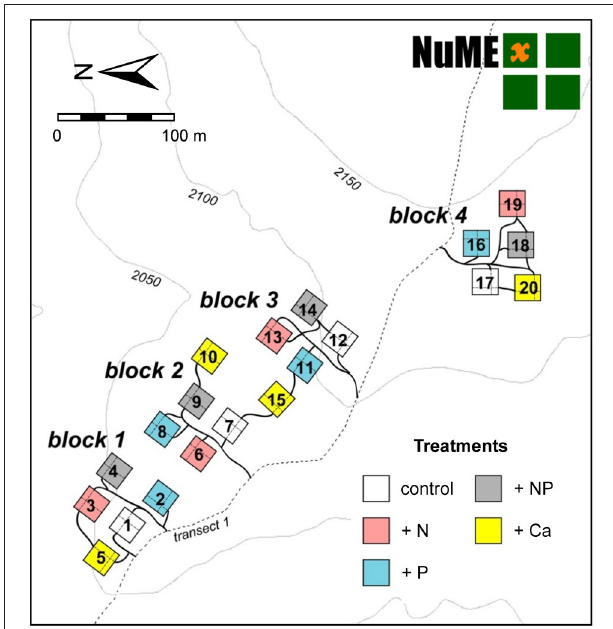
FIGURE 2 | Layout of the Nutrient Manipulation Experiment (NUMEX) in the Reserva Biológica San Francisco at 2000m a.s.l. The experiment site includes 20 plots in a fourfold replicated, randomized block design (four nutrient addition plots and one control treatment in each block).